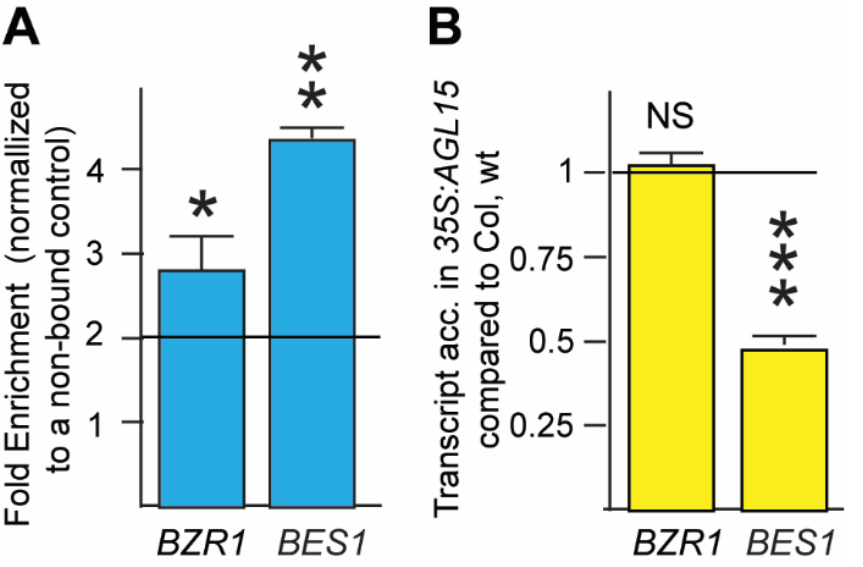
Figure 4. Confirmation of binding ( A ) and response ( B ) to AGL15. ( A ), qPCR results on two to three independent ChIP populations to assess the association of AGL15 with DNA regions associated with potential 5′ regulatory regions of BZR1 and BES1 compared to a region that is not bound by AGL15 (an intergenic region that is not bound based on ChIP-Chip and ChIP-Seq studies). Values greater than 2 (line) are considered as significant binding. ( B ) Response of transcript accumulation to AGL15. Overexpressing tissue of AGL15 ( 35S:AGL15 ) was compared to the wild type (Col, wt); biological replicate number of at least three biological replicates for both binding and response. * significant at p < 0.05; ** significant at p < 0.01; *** significant at p < 0.001, NS not significant at p < 0.05)